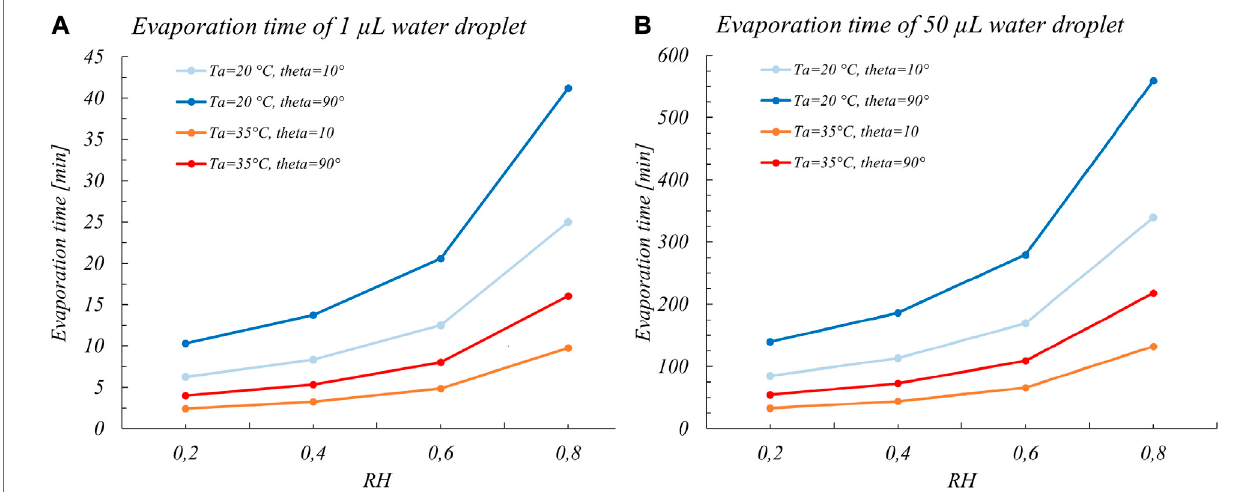
FIGURE 1 | Full evaporation times for (A) 1 µL and (B) 50 µL water sessile droplets vs RH considering two common temperatures of viability experiments (20 and 35 ° C) and for extreme contact angles for common surfaces. The values are calculated to gain corresponding orders of magnitudes of the evaporation times and thus were obtained with the Eq. 1 assuming a constant mass rate.